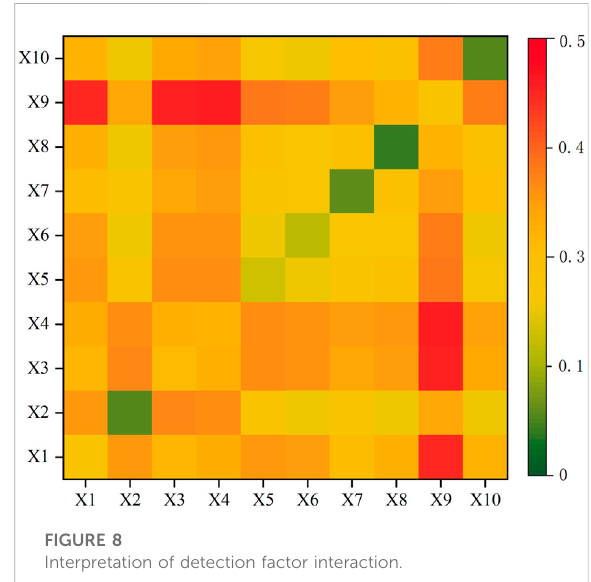
FIGURE 8 Interpretation of detection factor